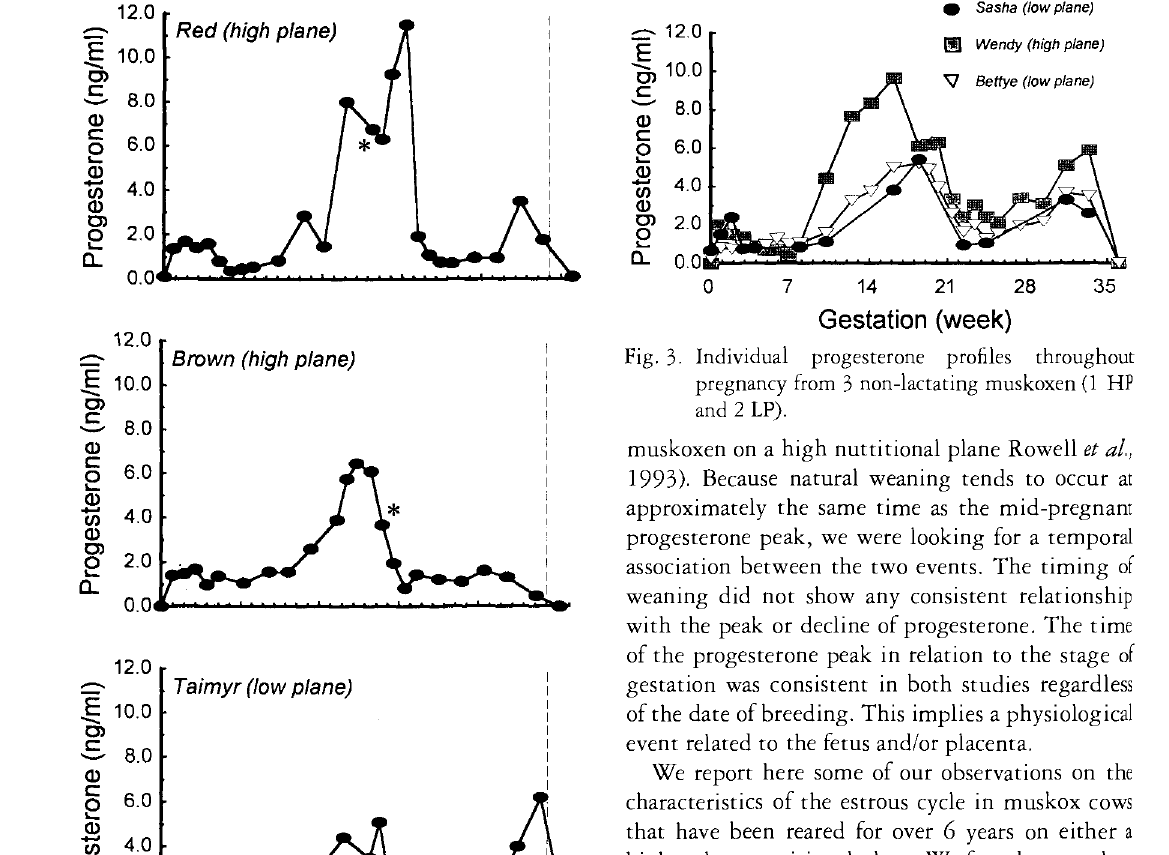
Fig. 2. Progesterone profiles from 3 individual musk- oxen throughout pregnancy. All cows (2 HP and 1 LP) were lactating during rhe first half of gesta tion. Weaning is indicated by the asterisk and calving by the dotted line.